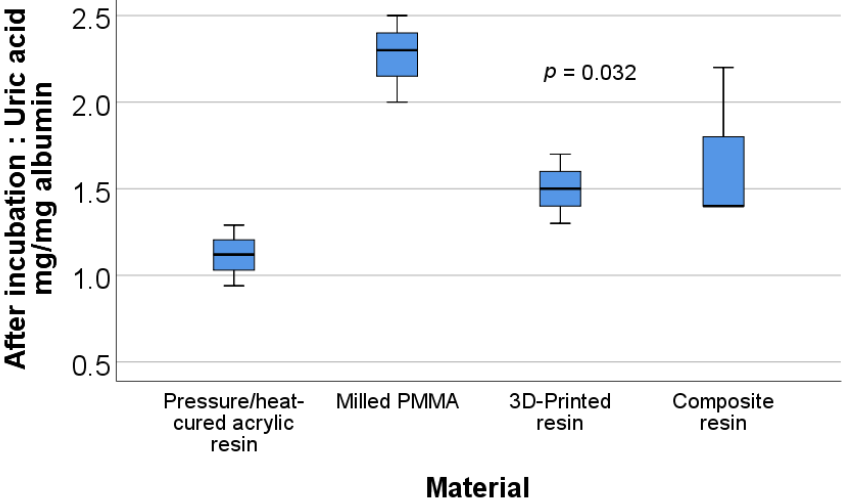
Figure 6. Box plot representation of the comparison between TNF α /albumin ratio values—after incubation for each material type.